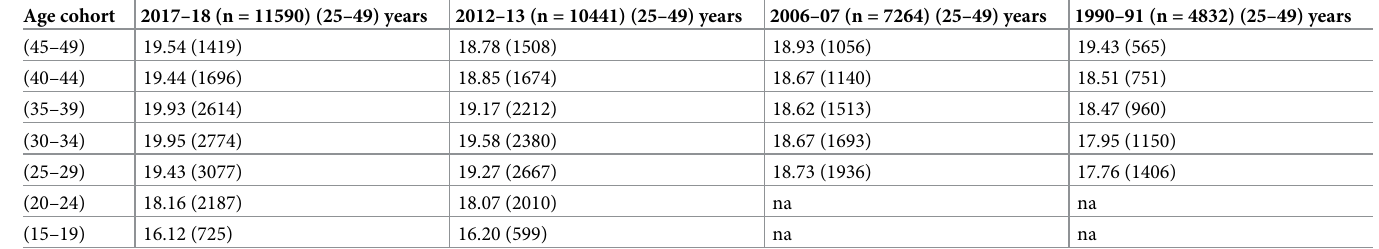
Table 2. Mean age at first marriage of currently married women by age at the time of the survey, Pakistan, 1990 to 2018: Four Pakistan Demographic and Health Surveys (PDHSs) (1990–91, 2006–07, 2012–13 and 2017–18). Age cohort